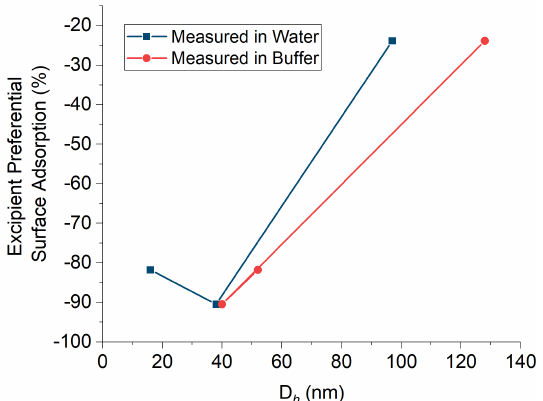
Figure 5. Excipient preferential surface adsorption is better predicted by D h in feed buffer than water. Unfunctionalised silica nanoparticles of D h = 16, 38, and 97 nm were compared. The D h of nanoparticles measured in water was not predictive of D h in buffer. Particles of D h = 16, 38, and 97 nm in water were measured to be 52, 40, and 128 nm, respectively in pH 5.5 feed buffer.